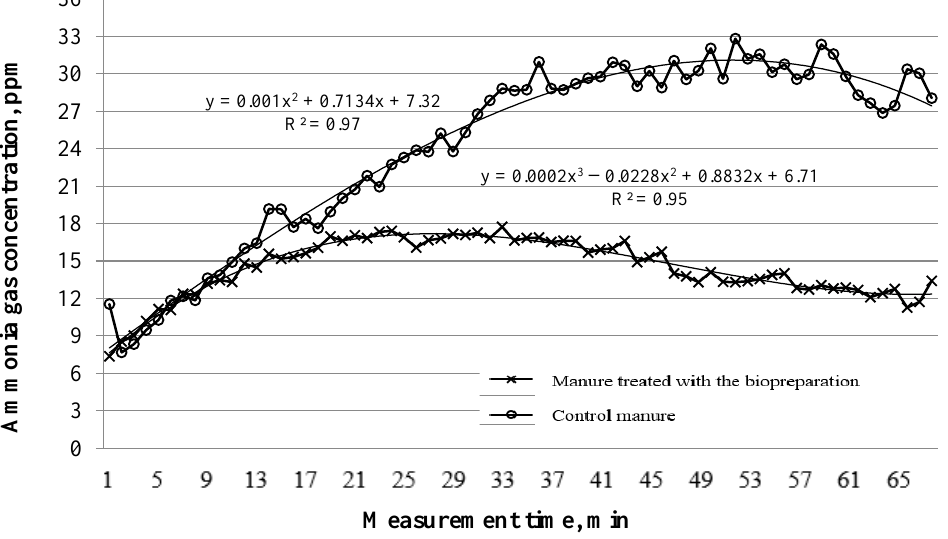
Figure 2. Change in the ammonia concentration in the wind tunnel with time after addition of manure sprayed with biopreparation (biologically treated manure) or the manure without additives (control).